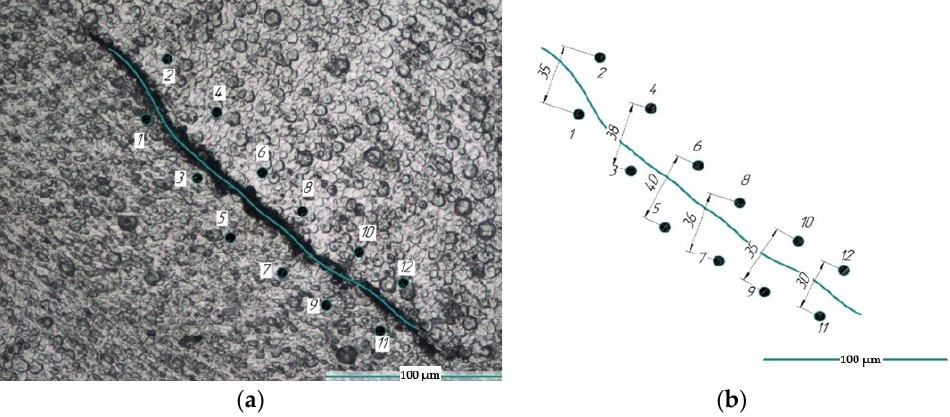
Figure 6. Crack in sample EP648 obtained by L-DED method with chemical composition measurement points ( a ), distances between chemical composition measurement points and CIC value between pairs of points ( b ). Table 4. Atomic concentration (without C) at point.